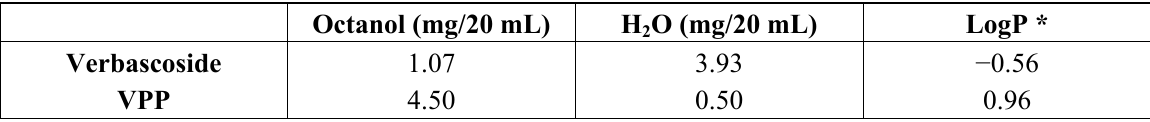
Table 1. Partition coefficients of verbascoside and VPP in a biphasic mixture of octanol and water.